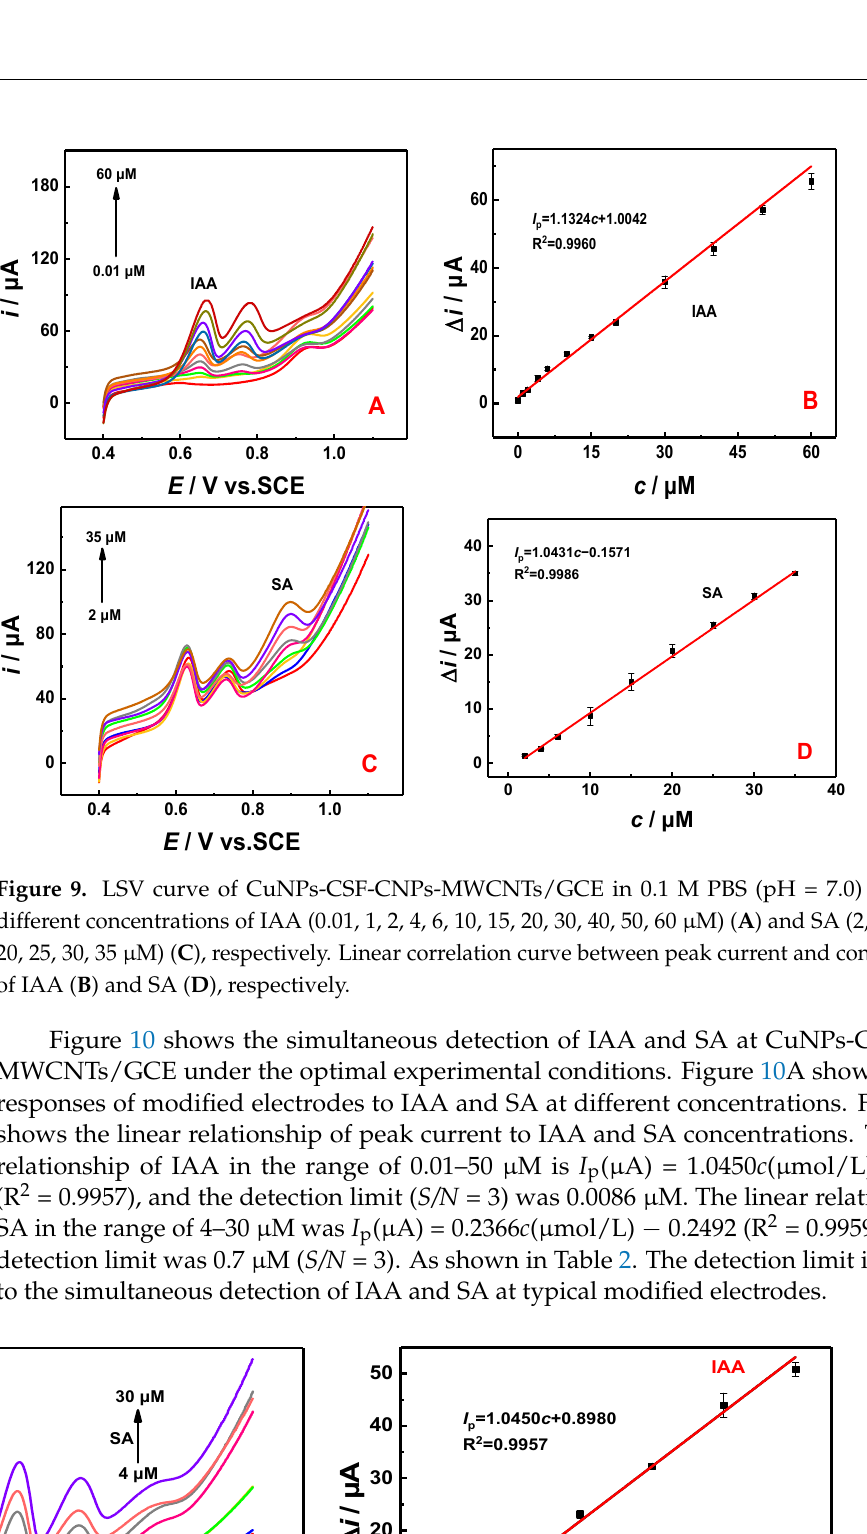
Figure 10. LSV ( A ) curve of CuNPs-CSF-CNPs-MWCNTs/GCE in 0.1 M PBS (pH = 7.0) containing different concentrations of IAA (0.01, 0.1, 5, 10, 20, 30, 40, 50 µ M) and SA (4, 6, 10, 14, 18, 22, 26, 30 µ M). Linear correlation curve between peak current and concentrations of IAA and SA ( B ),